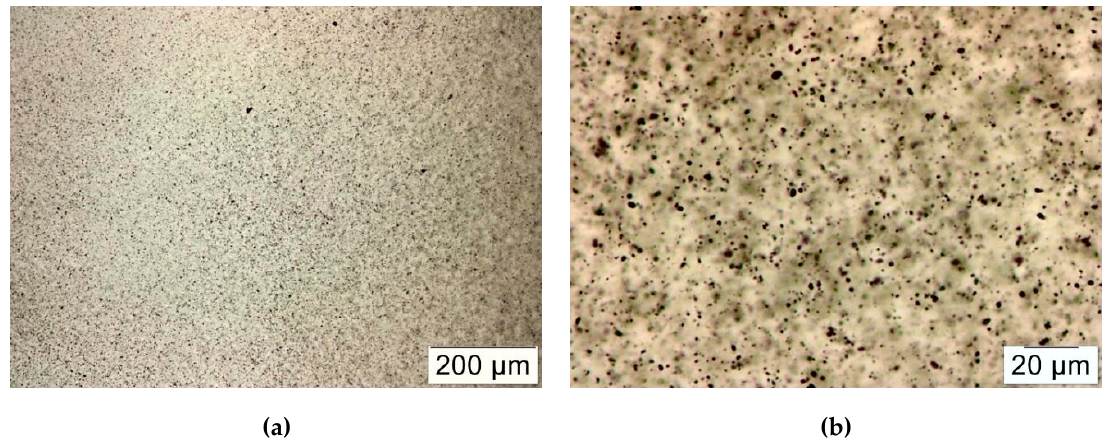
Figure 1. Optical light microscope images of oxidized MWCNT/epoxy dispersions at different magnifications, ( a ) 200 μ m; ( b ) 20 μ